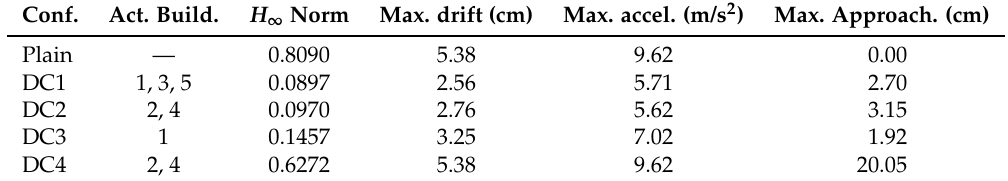
Table 3. H ∞ norm and overall maximum peak-values corresponding to the nonactuated multibuilding system (plain configuration), the linked configurations DC1, DC2 and DC3, and the unlinked configuration